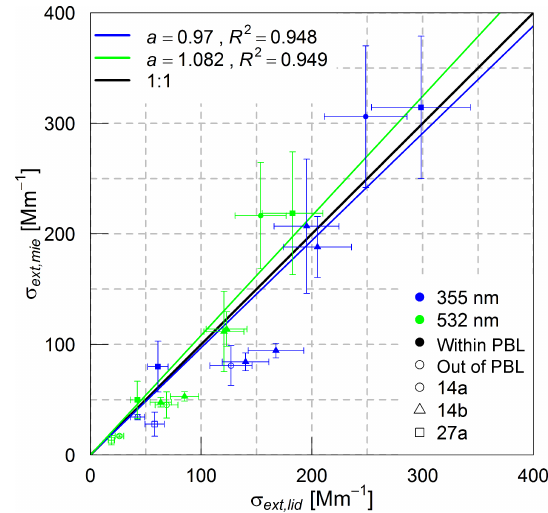
Figure 15. Scatterplot of the airborne-based ( σ ext, mie ) and the lidar-based ( σ ext, lid ) particle light extinction coefficients for all horizontal legs during the investigated days for the wavelengths λ = 355 (blue) and 532nm (green). σ ext, lid derived with a LR of 55sr. The error bars represent the assumed 15% error for the lidar measurements and 3 times the standard deviation of the mean of the result of the Mie calculations. Lines and symbols as in Fig.